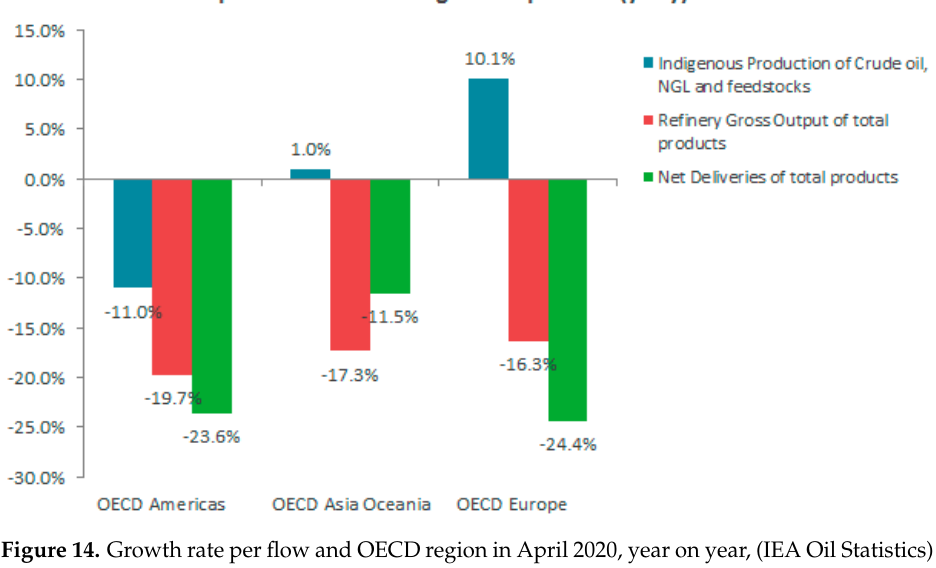
Figure 14. Growth rate per flow and OECD region in April 2020, year on year, (IEA Oil Statistics) [99].